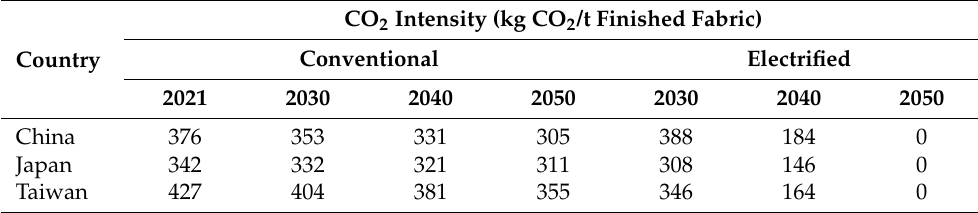
Table 10. The CO 2 intensity of the conventional and electrified singeing process. CO 2 Intensity (kg CO 2 /t Finished Fabric) Conventional Electrified Country 2021 2030 2040 China 376 353 331